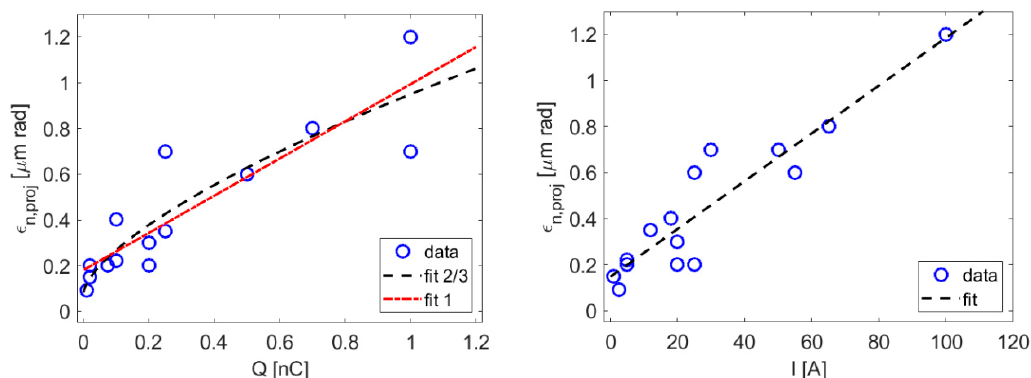
Figure 4. Normalized transverse projected emittance as function of the bunch charge (left) and peak current (right), and best fit from Equation (4) (left, “fit 2/3”), Equation (5) (left, “fit 1”) and Equation (6) (right). Data collected from [18,19,38–41].